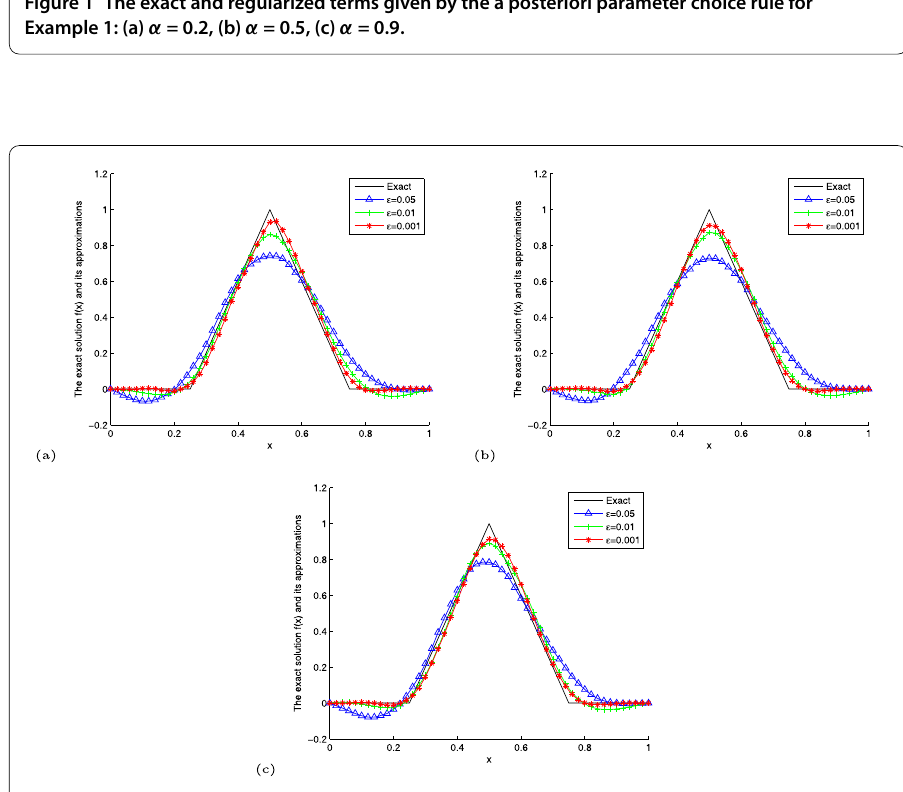
Figure 2 The exact and regularized terms given by the a posteriori parameter choice rule for Example 2: (a) α = 0.2, (b) α = 0.5, (c) α =